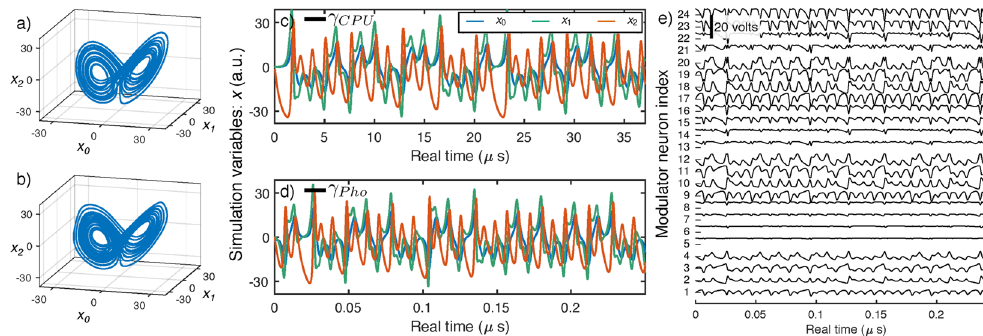
Figure 4. Photonic CTRNN benchmarking against a CPU. ( a , b ) Phase diagrams of the Lorenz attractor simulated by a conventional CPU ( a ) and a photonic CTRNN ( b ). ( c , d ) Time traces of simulation variables for a conventional CPU ( c ) and a photonic CTRNN ( d ). The horizontal axes are labeled in physical real time, and cover equal intervals of virtual simulation time, as benchmarked by γ CPU and γ Pho . The ratio of real-time values of γ ’s indicates a 294-fold acceleration. ( e ) Time traces of modulator voltages s i (minor y-axis) for each modulator neuron i (major y-axis) in the photonic CTRNN. The simulation variables, x , in ( d ) are linear decodings of physical variables, s , in ( e